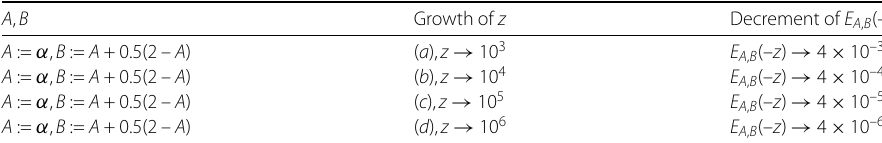
Table 4 Numerical data corresponding to Fig. 2 A , B Growth of z Decrement of E A , B (– z